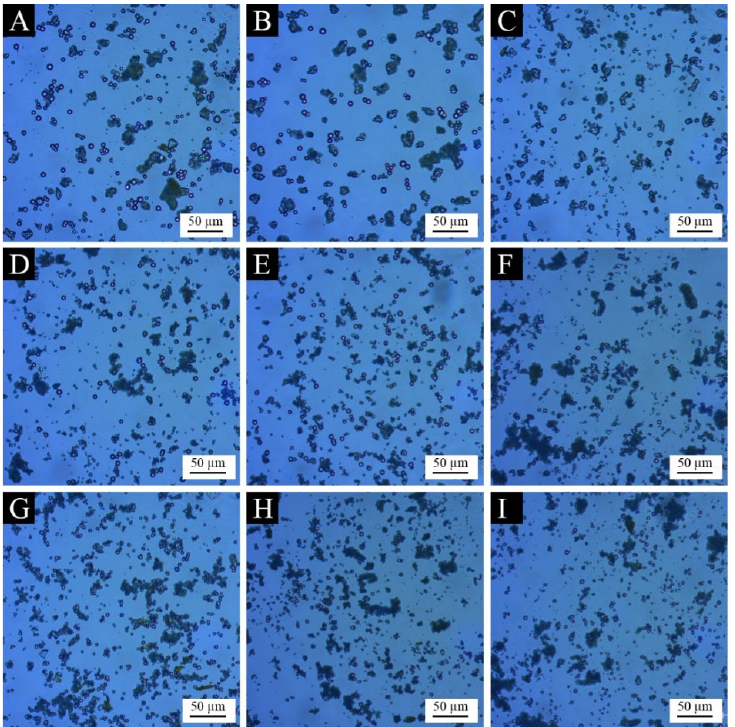
Figure 4. OM images of microcapsules in the orthogonal test: ( A ) sample 1, ( B ) sample 2, ( C ) sample 3, ( D ) sample 4, ( E ) sample 5, ( F ) sample 6, ( G ) sample 7, ( H ) sample 8 and ( I ) sample 9.